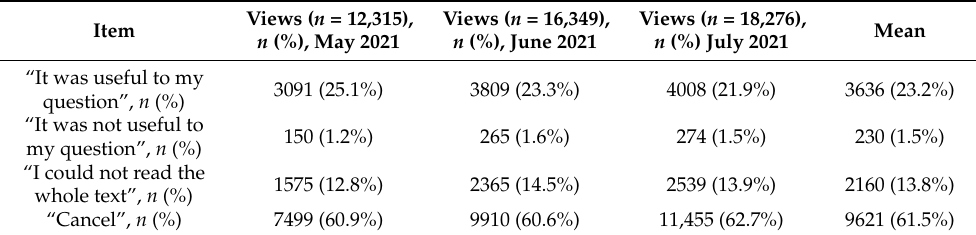
Table 5. Answers from viewers to the pop-up questionnaire for 3